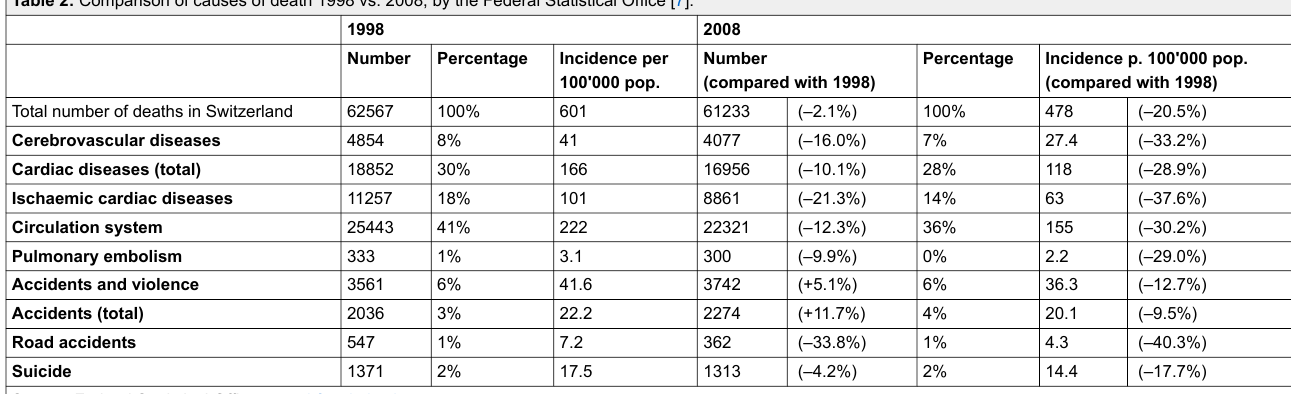
Table 2: Comparison of causes of death 1998 vs. 2008, by the Federal Statistical Office